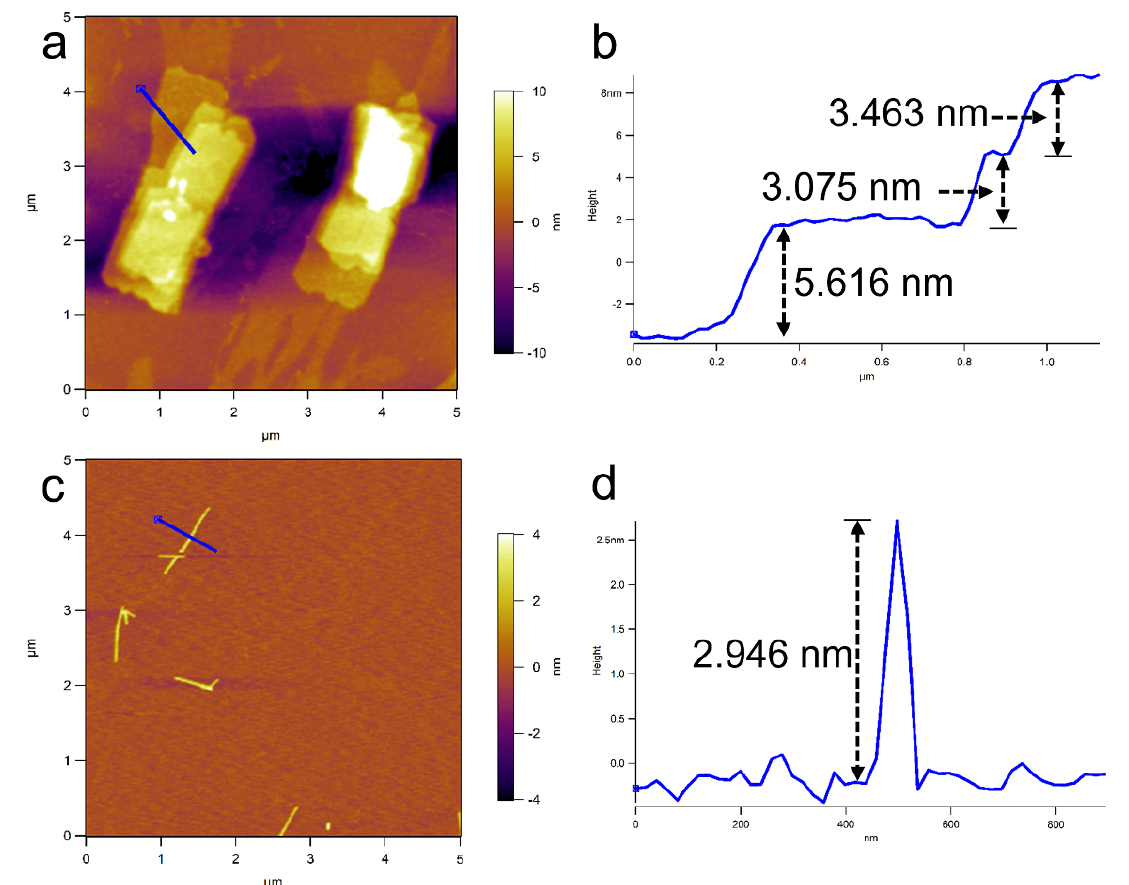
Figure 3. AFM images of the nanostructures self-assembled by P3HT 22 - b -PEG 43 ( a , b ) and P3HT 22 - b - PEG 113 ( c , d ) in i -PrOH with the polymer concentration at c = 0.005 mg . mL − 1 , the arrows represent the heights of each laminar layer or the single fiber.